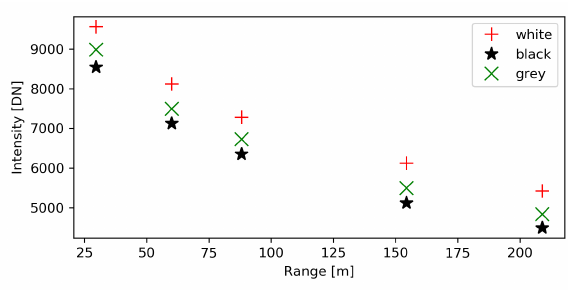
Figure 6. VZ-2000i recorded intensity vs. range for a constant incidence angle of 0 ◦ .